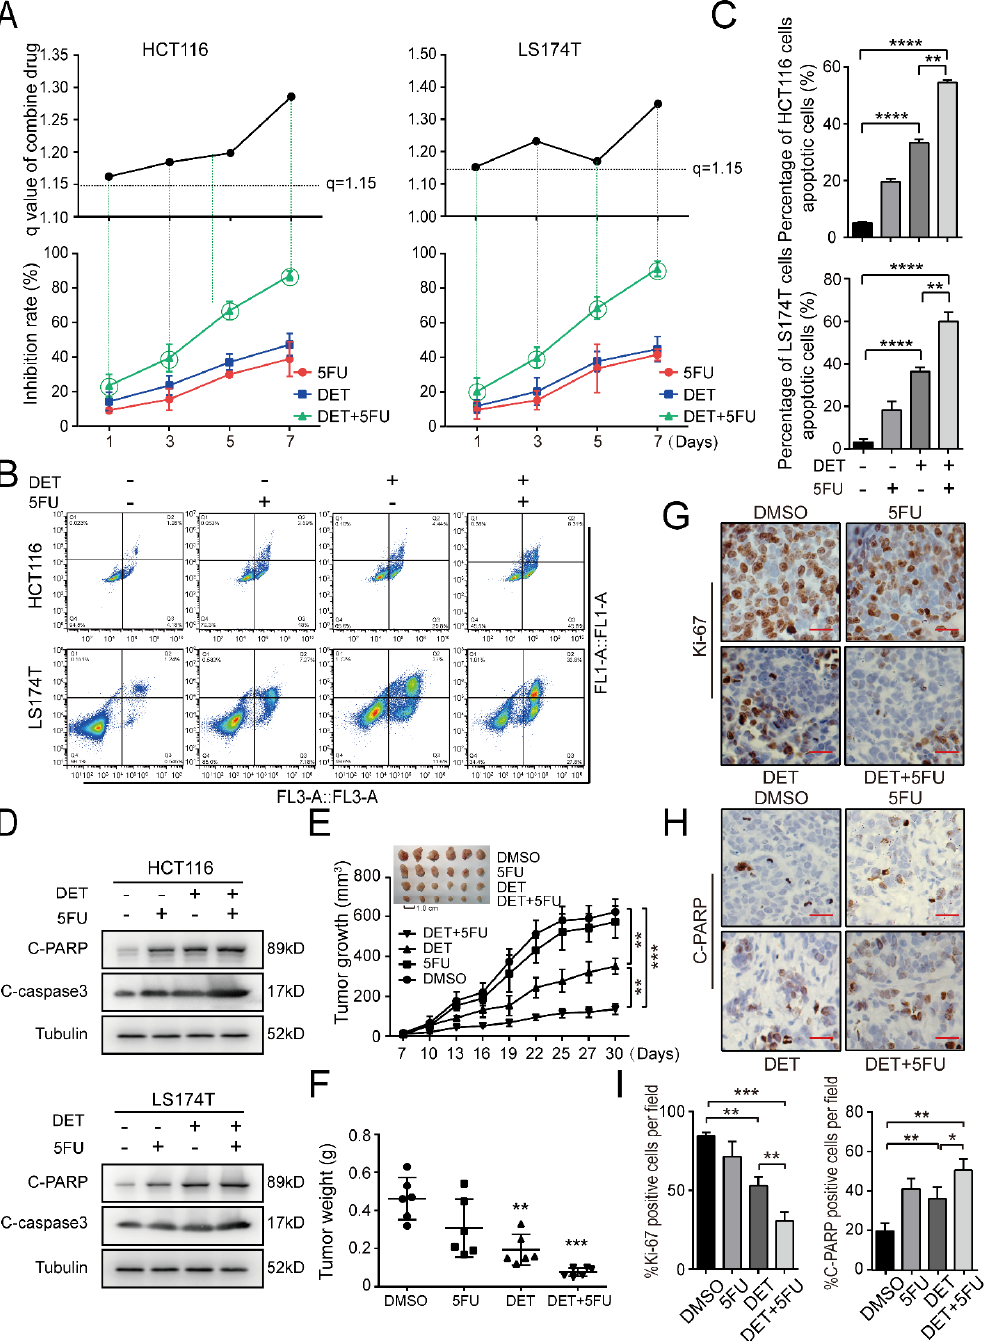
Figure 6. DET enhances chemosensitivity to 5-Fluorouracil (5FU). ( A ) A panel of colon cell lines was treated with 5 µM DET, with or without 5FU (5 µM), for 1, 3, 5, 7 d. ( B ) HCT116 and LS174T cells were treated with 5 µM DET, with or without 5FU (5 µM), and the apoptosis was detected with flow cytometry. ( C ) Quantification results of apoptosis rate of HCT116 and LS174T cells. ( D ) HCT116 and